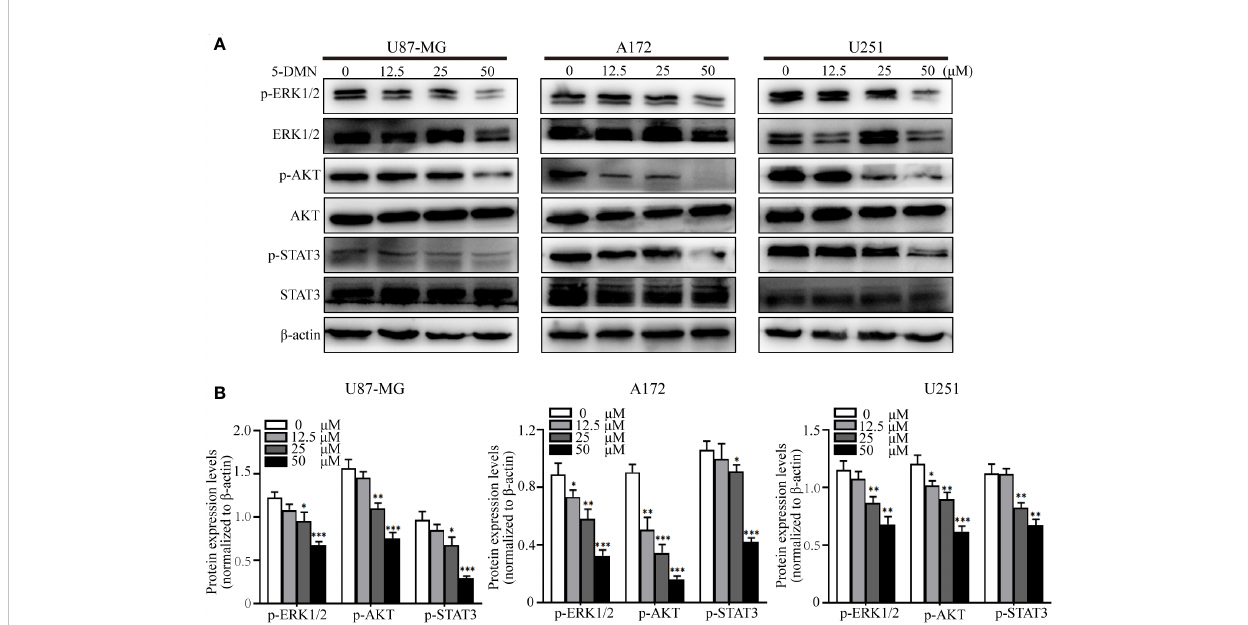
FIGURE 4 5-DMN inhibits the ERK1/2, AKT and STAT3 pathways in GBM cells. Cultured U87-MG, A172 and U251 cells were incubated with or without 50 µM 5-DMN for 48 h. (A) Western blotting analysis of the expression of p-ERK1/2, ERK1/2, p-AKT, AKT, p-STAT3 and STAT3. (B) The relative protein levels of p-ERK1/2, p-AKT and p-STAT3 in 5-DMN-treated GBM cells were analyzed. The protein levels in the untreated group were used to standardize the relative protein ratio. *p<0.05, **p<0.01, ***p<0.001 vs. cells in the untreated